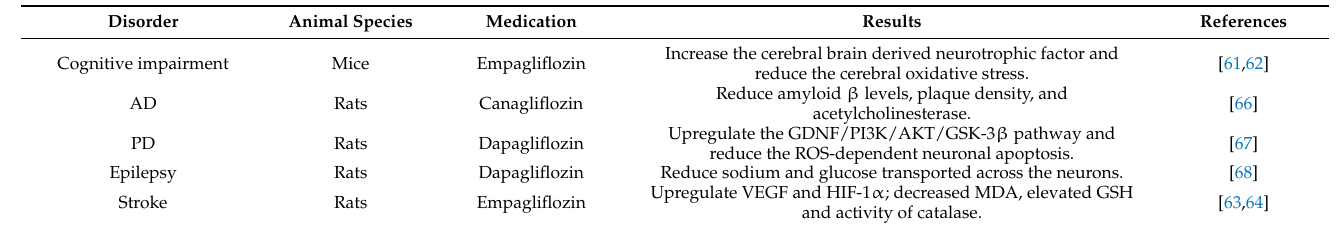
Table 2. Preclinical evidence of the reparative implications of the SGLT2 inhibitors in neurological disorders.